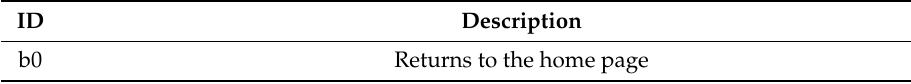
Table 11. Description of the button found on the “test complete” page.